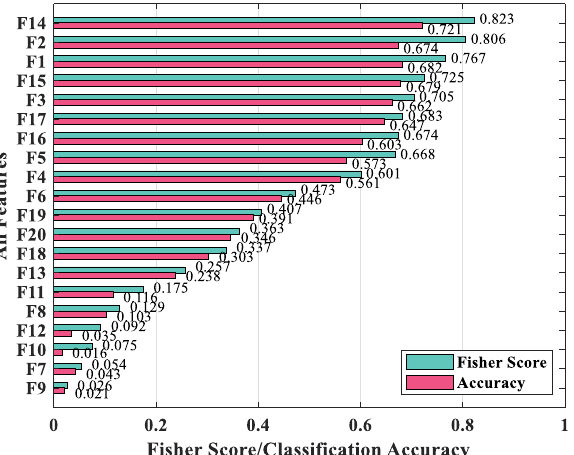
Figure 2. The relationship between the Fisher s core and the feature’s impact on the final classification accuracy for all accuracy for all features.